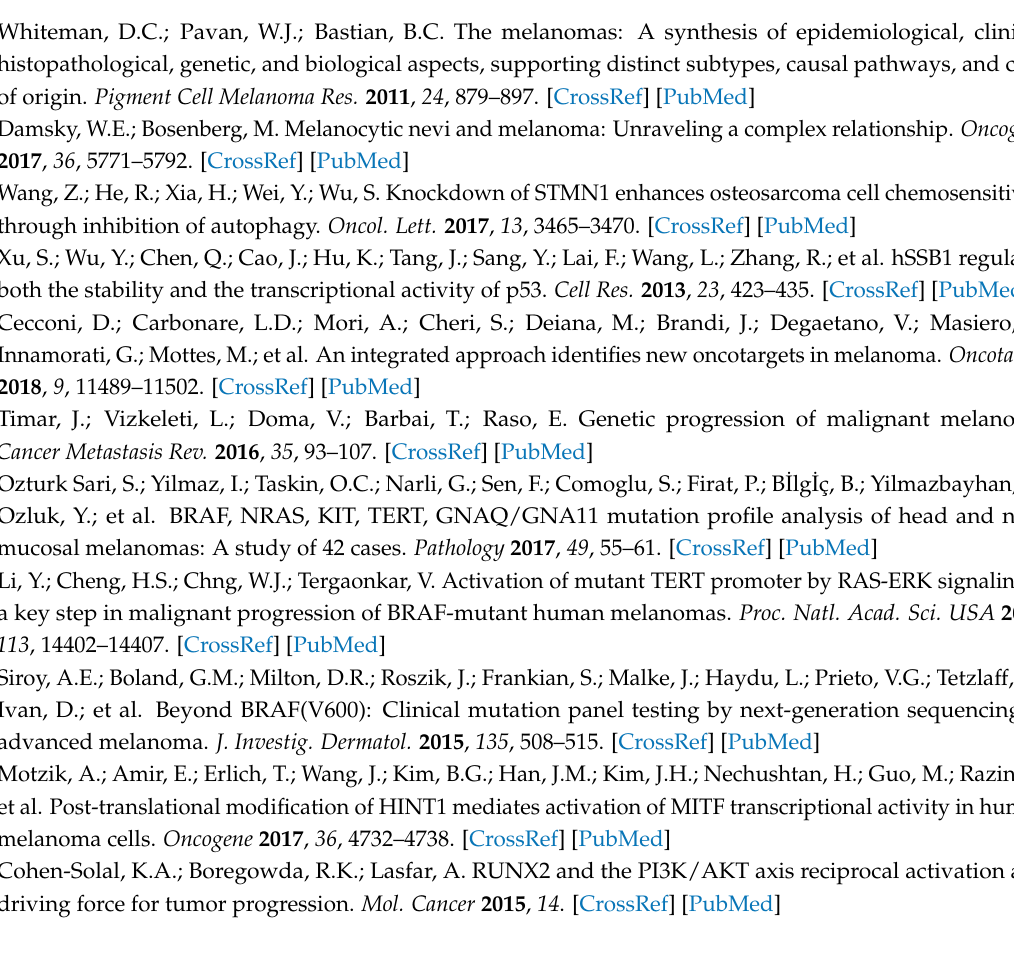
Figure S1: Protein-protein functional association, Figure S2: Representative image of a Western